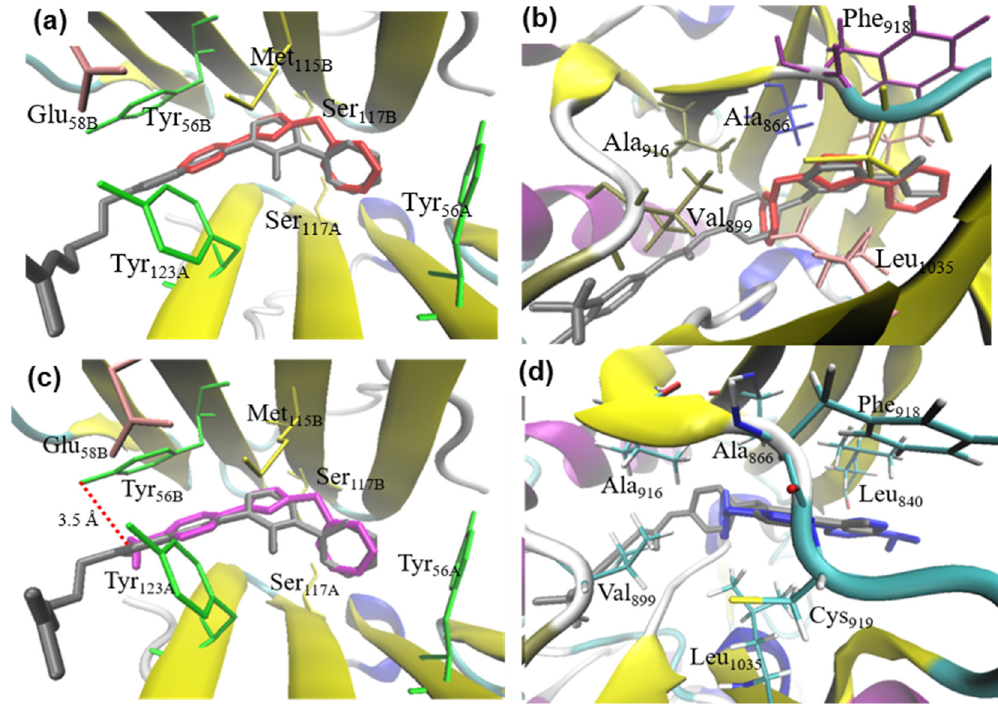
Figure 3. ( a ) Superposition of triazole 1 (red) and BMS-202 (gray) at the PD-L1 binding site. ( b ) Superposition of aryl triazole 1 (red) and sorafenib (gray) at the tyrosine kinase domain in VEGFR-2. ( c ) Superposition of aniline triazole 14 (magenta) and BMS-202 (gray) at the PD-L1 binding site. ( d ) Superposition of aniline triazole 14 (blue) and sorafenib (gray) at the tyrosine kinase domain in VEGFR-2.